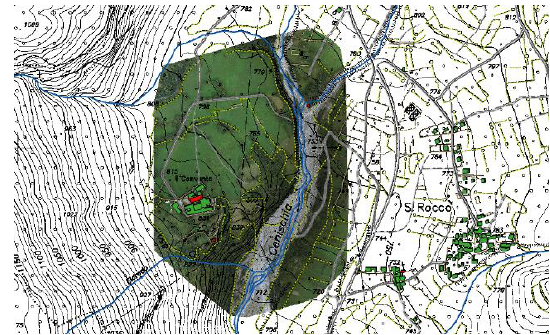
Figure 3. Estension of orthophoto compared with regional